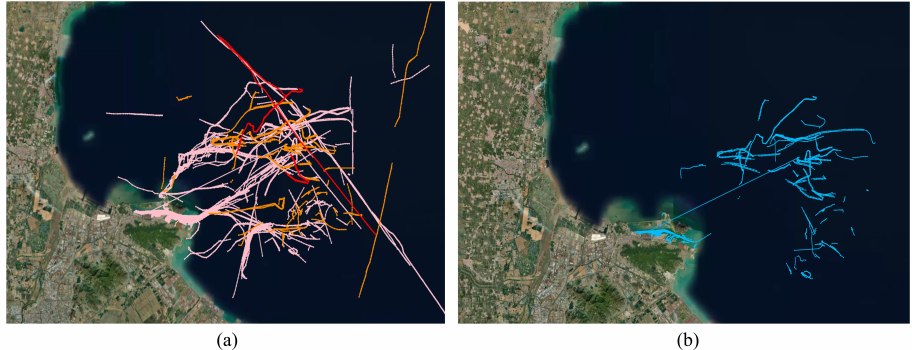
Figure 13. The trajectories of suspected events in traffic flow area: ( a ) adaptive threshold method (High-red line, Medium-yellow line, Low-pink line); ( b ) Fixed threshold